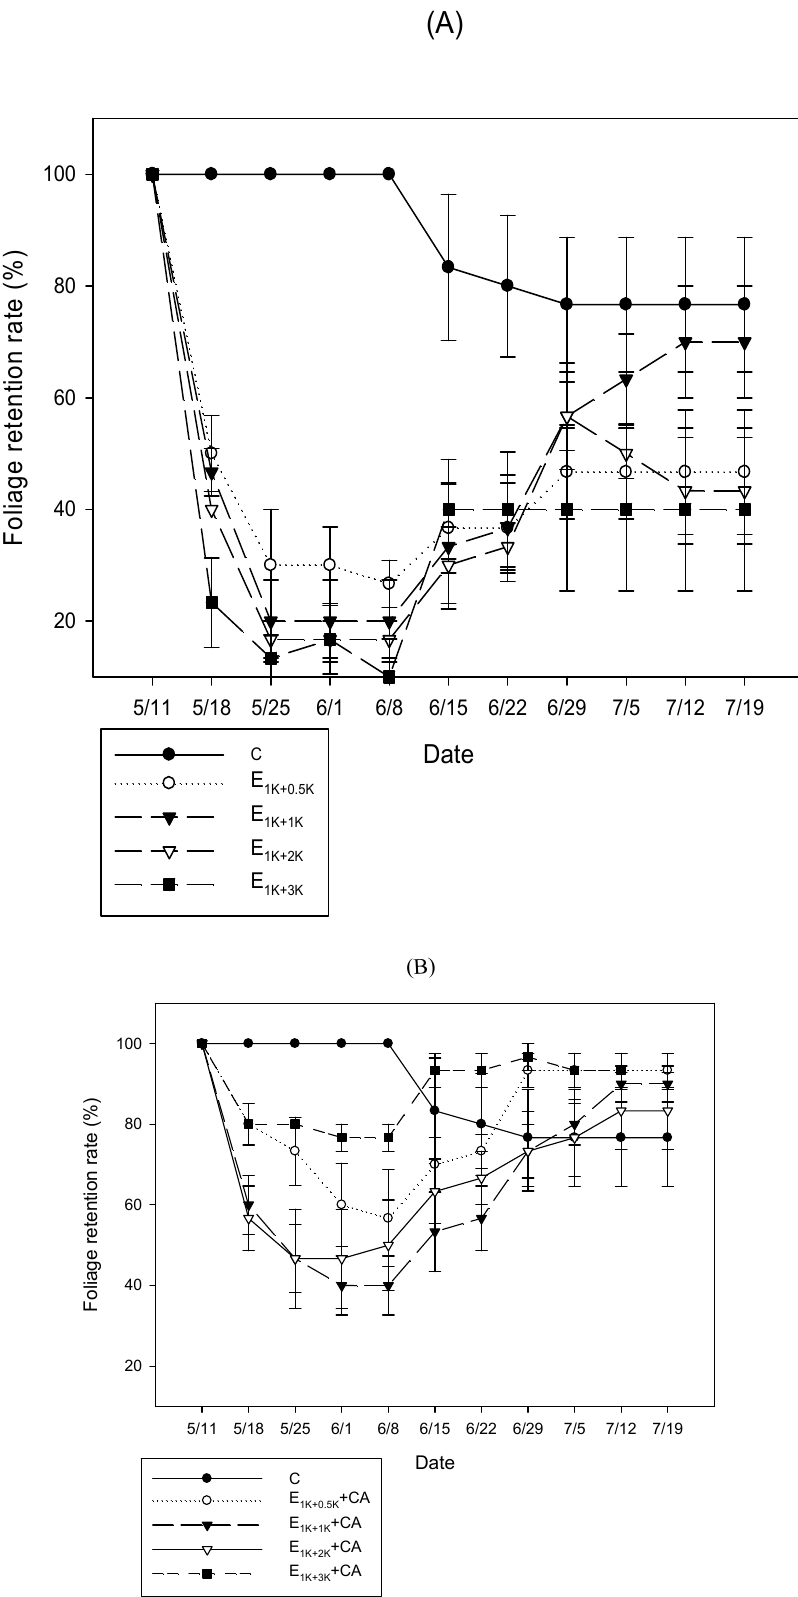
Figure 3. Foliage retention rate movement of camphor trees between 11 May and 19 July under ethephon and ethephon + CA treatments. The control plants defoliated after 15 June due to summer stress. ( A ) Pure ethephon treatments. ( B ) Ethephon + CA